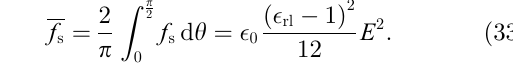
Figure 6. Temporal evolution of R a at different distances between bubble centers ( L ) ( T = 50 l s, R a 0 =4.5 l m).